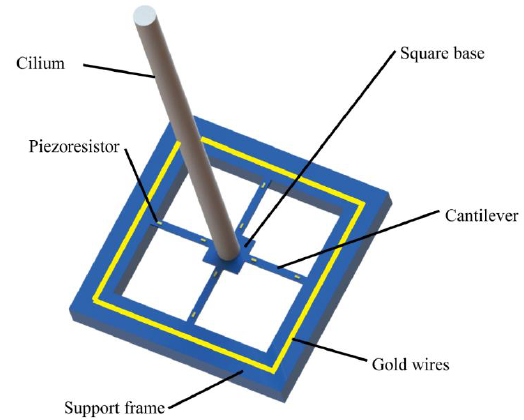
Figure 7. Structural design of a self-developed turbulence sensor.